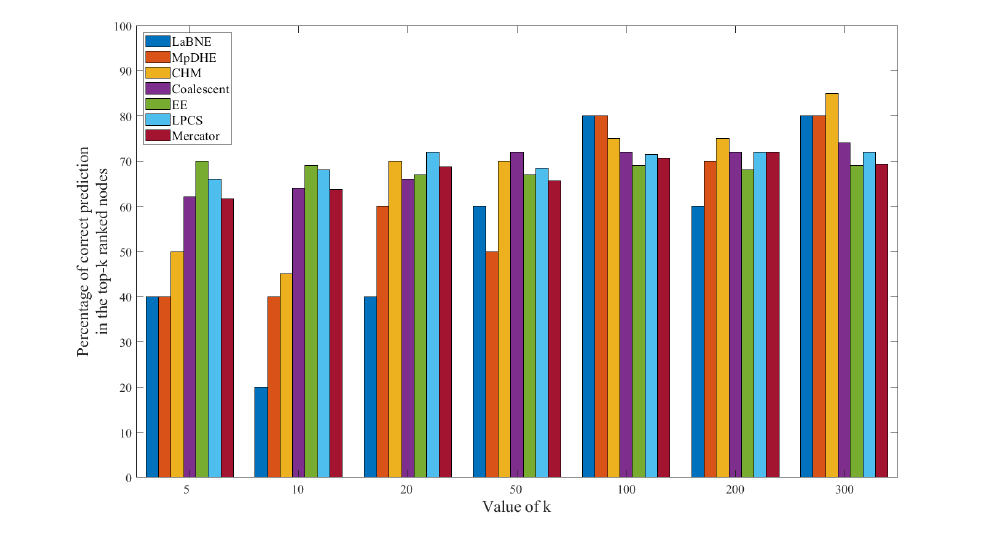
Figure 9. The proportion of correct predictions in top-k nodes on the nPSO-1